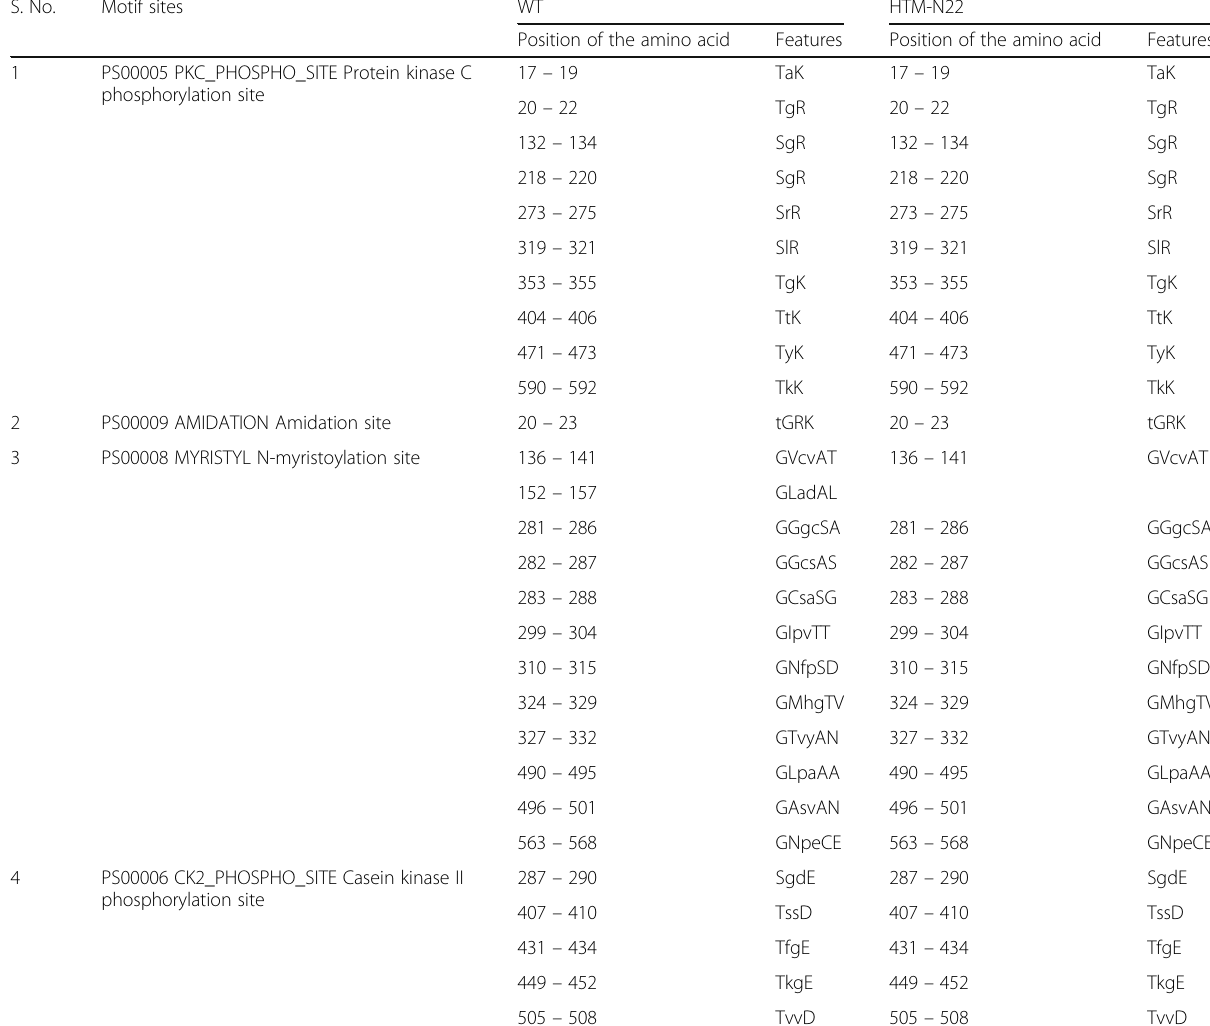
Table 5 Functional motifs predicted in ALS proteins of WT and HTM-N22 S.